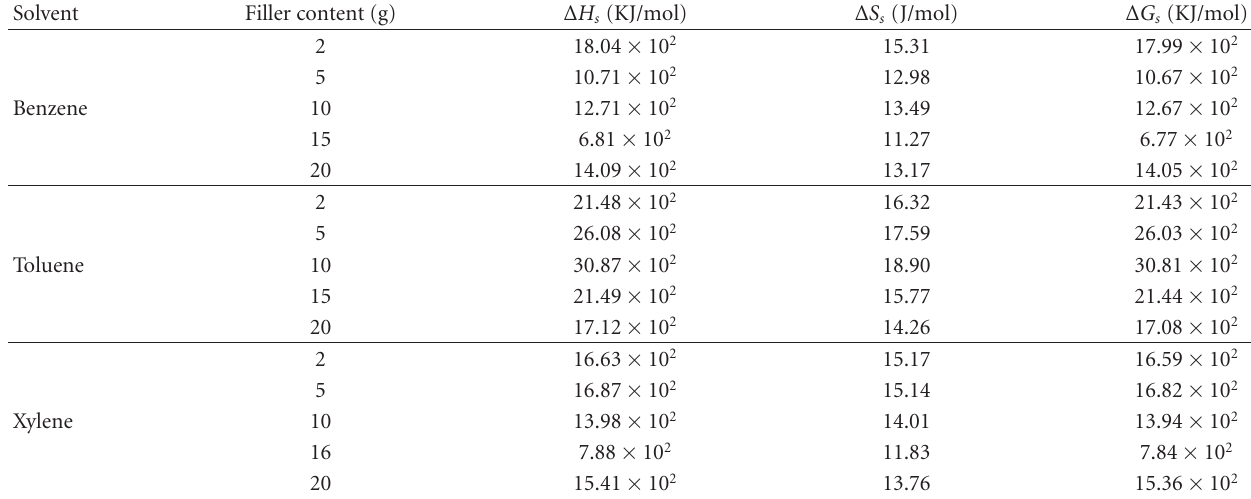
Table 8: Values of enthalpy of absorption ( Δ H s ), entropy of absorption ( Δ S s ), and Gibbs free energy ( Δ G s ) of snail shell powder filled natural rubber (filler particle size, 0.300 μ